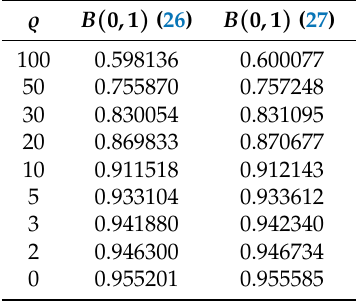
Table 8. Sensitivity analysis of bond price B ( 0,1 ) for the parameter (cid:36) .